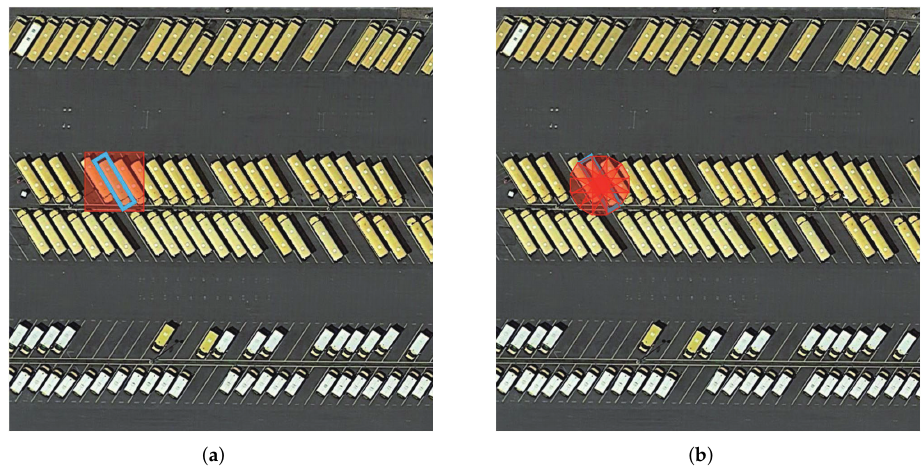
Figure 1. Disadvantages of anchor-based detectors. The blue rectangle represents the ground truth, and the orange rectangle represents the anchor box. ( a ) The horizontal anchor contains massive ground pixels and other objects. ( b ) RRPN often places too many oriented anchors to ensure a high recall